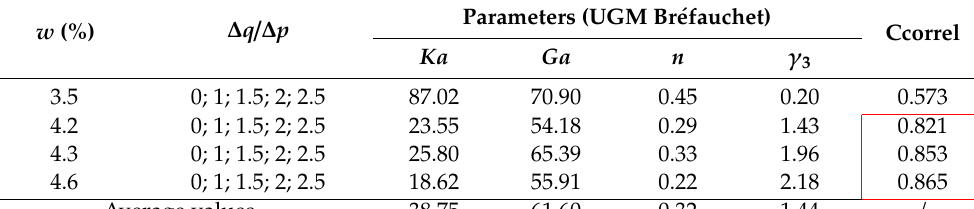
Table 5. Parameter optimization of Equations (8)–(11) for UGM Bréfauchet with γ 1 .